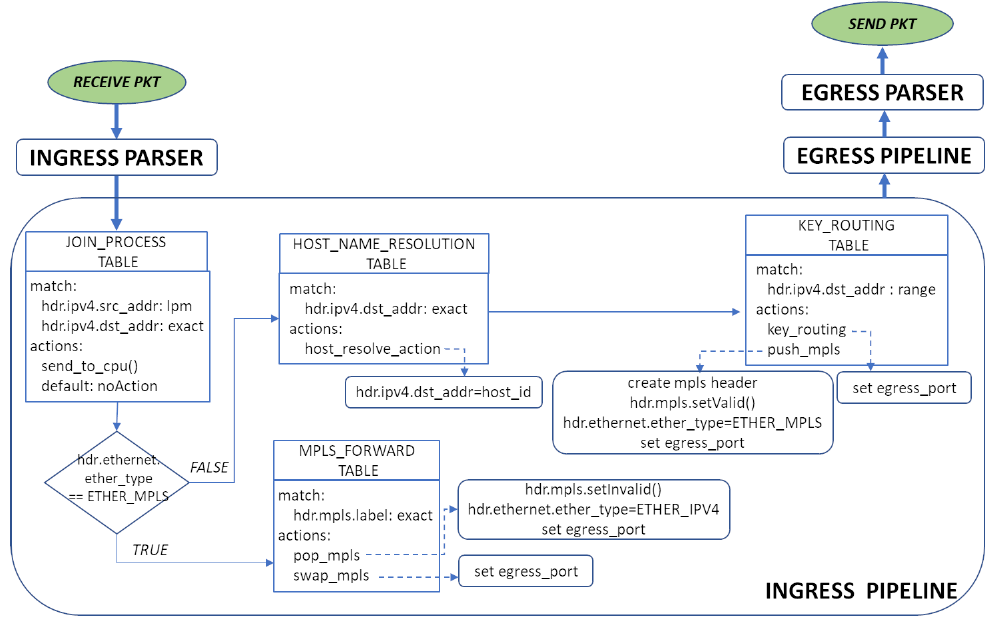
Figure 5. Tables and actions in the ingress